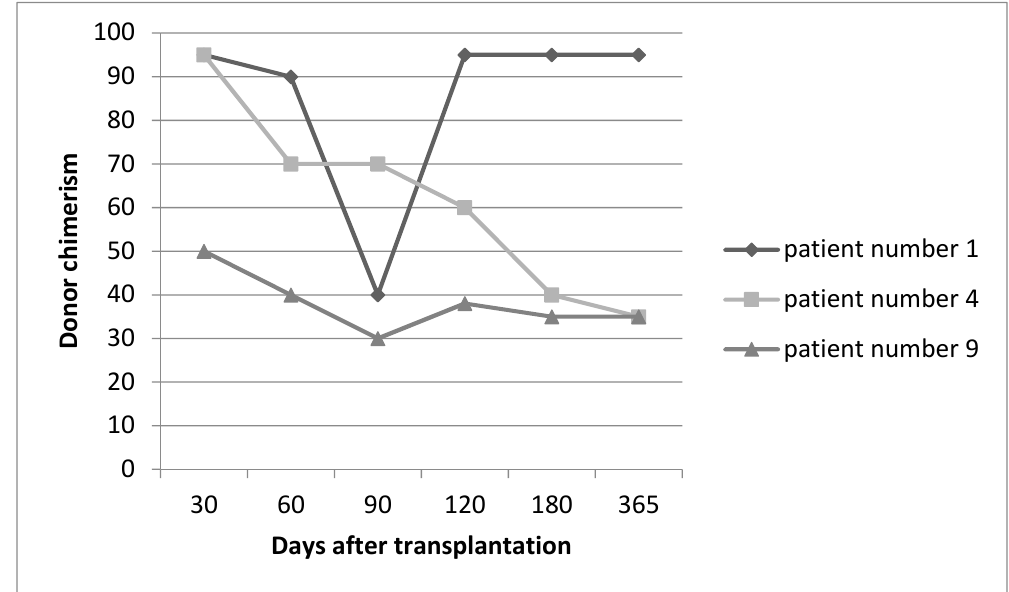
Figure 1. Sequence of donor chimerism in three representative patients who underwent DLI.